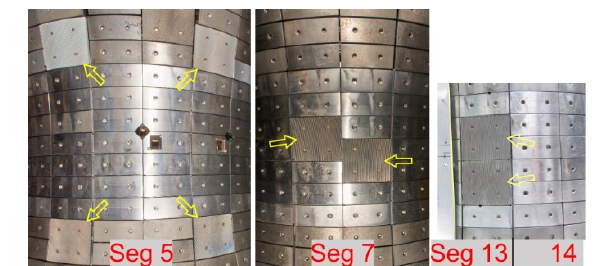
Fig. 3. AUG vacuum vessel heat shield, which consists of tiles. The view is radially inward towards the central column of the machine. The visible double tiles are the reflecting gratings that correspond to the launchers from figure 2. Left: Four gratings for the launchers of segment 5. Note, that the gratings are not in the midplane. Middle: Two gratings in segment 7 for the two single launchers of segments 6 and 8. Right: Two gratings in segments 13 for the double launcher of segment 14.